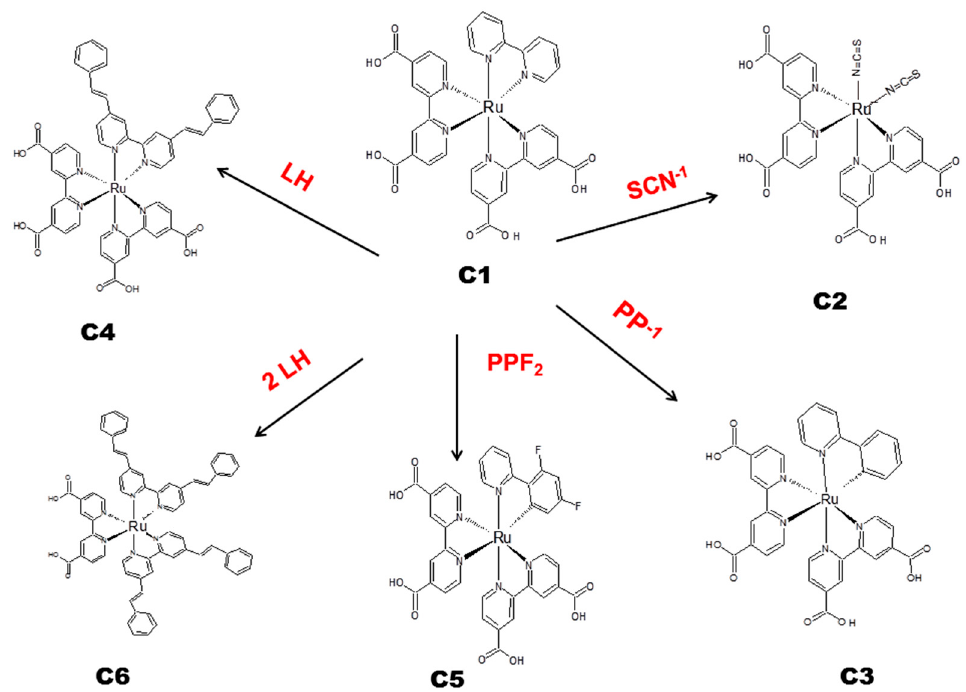
Figure 21. Complexes employed in this study. C1 is the base complex, and the effect on the cell efficiency of replacing the 2,2’-bpy ligand by: SCN − (C2), PP − 1 (C3), LH (C4), PPF 2 (C5) and two LH gives (C6).